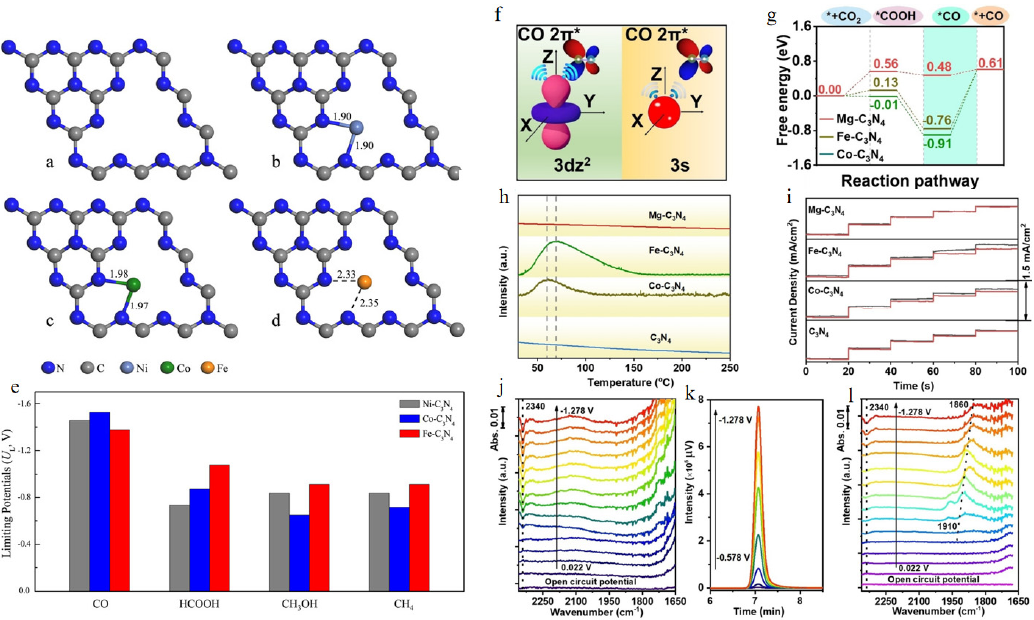
Figure 5. Optimized structure diagram of g-C 3 N 4 ( a ), Ni-C 3 N 4 ( b ), Co-C 3 N 4 ( c ) and Fe-C 3 N 4 ( d ); ( e ) Histogram of production-related limiting potentials for CO, HCOOH, CH 3 OH, and CH 4 , reprinted with permission from ref. [36], Copyright 2019, ChemSusChem; ( f ) schematic diagram comparison for CO adsorbed on 3 dz 2 and 3 s orbits; ( g ) free energy diagram of Mg-C 3 N 4 CO 2 RR, desorption capacity of CO on Mg-C 3 N 4 ; ( h ) CO-TPD curve; ( i ) electrode current density in electrical response measurement under Ar and CO; ( j ) Mg-C 3 N 4 ATR-IR spectra in situ; ( k ) Mg-C 3 N 4 ATR-IR spectra in situ producing CO gas chromatograph (GC) spectra; ( l ) ATR-IR spectra of Fe-C 3 N 4 in situ [86], Copyright 2021, Wiley-VCH GmbH.